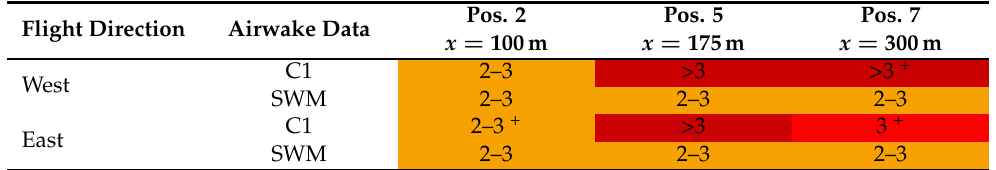
Table 9. Summary of the assessment of the non-piloted simulations with the ADS-33 offline criteria. Flight Direction Airwake Data